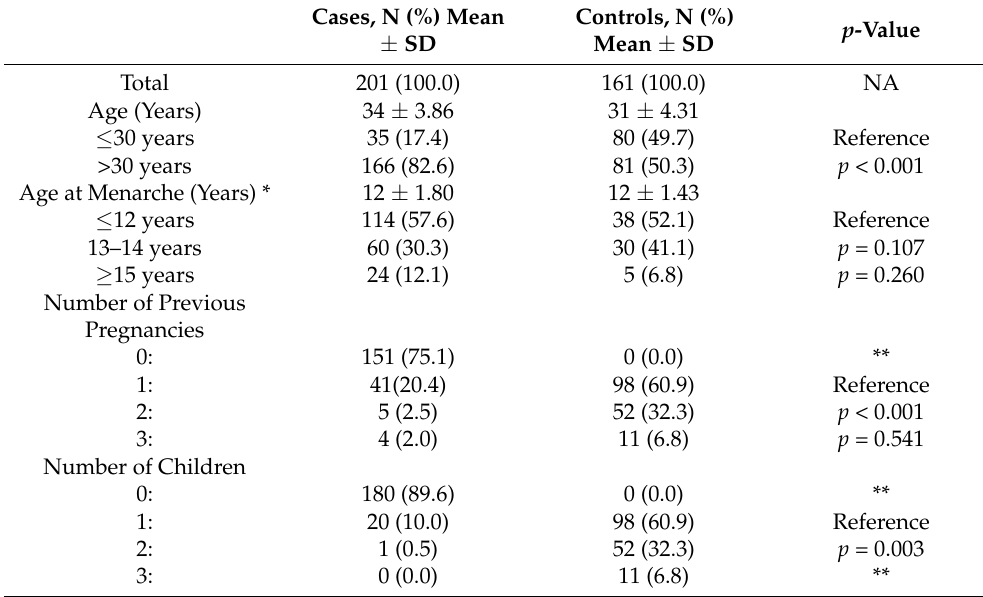
Table 3. Clinicopathological characteristics of cases (infertile women) and controls (fertile